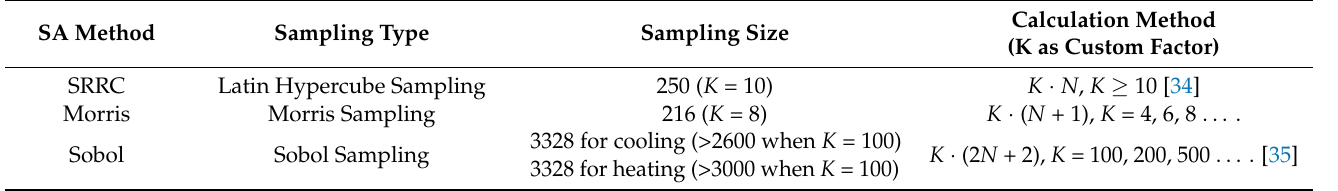
Table 1. The sampling type and scale specified by different SA methods in different stages.